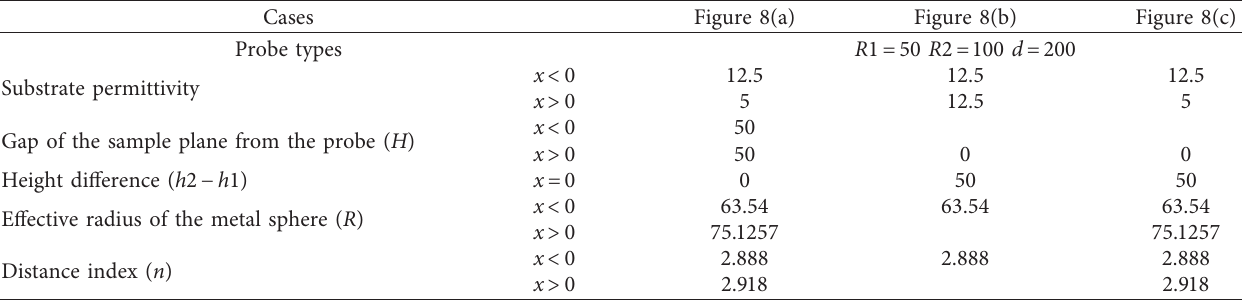
Figure 8: (a) Scattering near-field contrast curves of samples with different dielectric constants on both sides of the dividing line. The dividing line is x � 0. (b) Scattering near-field contrast curves of samples with different heights on both sides of the dividing line. The dividing line is located at x � 0. (c) Near-field contrast curves with different dielectric constants and heights on both sides of the sample dividing line. The dividing line is at x � 0. Table 2: Cases of the study for the scattered near-field contrast curves of samples (unit: